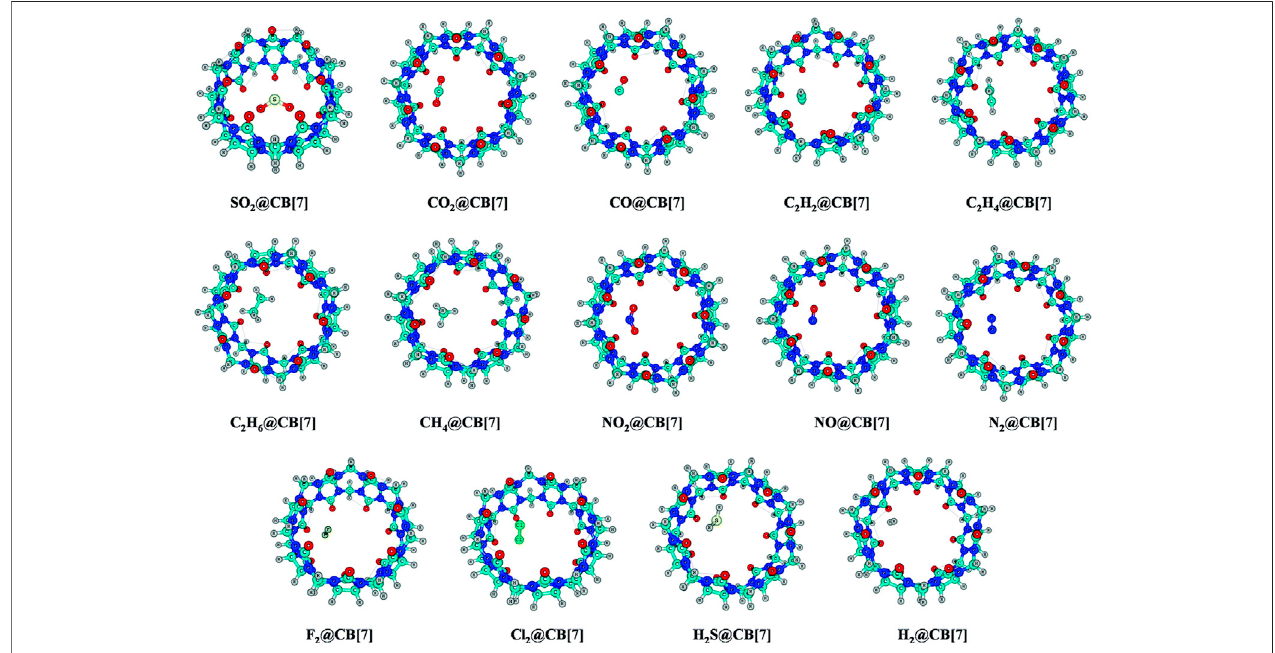
FIGURE7| Optimized geometriesoftheguestencapsulatedCB[7] systemsatthe ω B97X-D/6-311+G(d,p) level oftheory.(Reproduced fromPanetal.,2017with permission from the PCCP Owner Societies.).